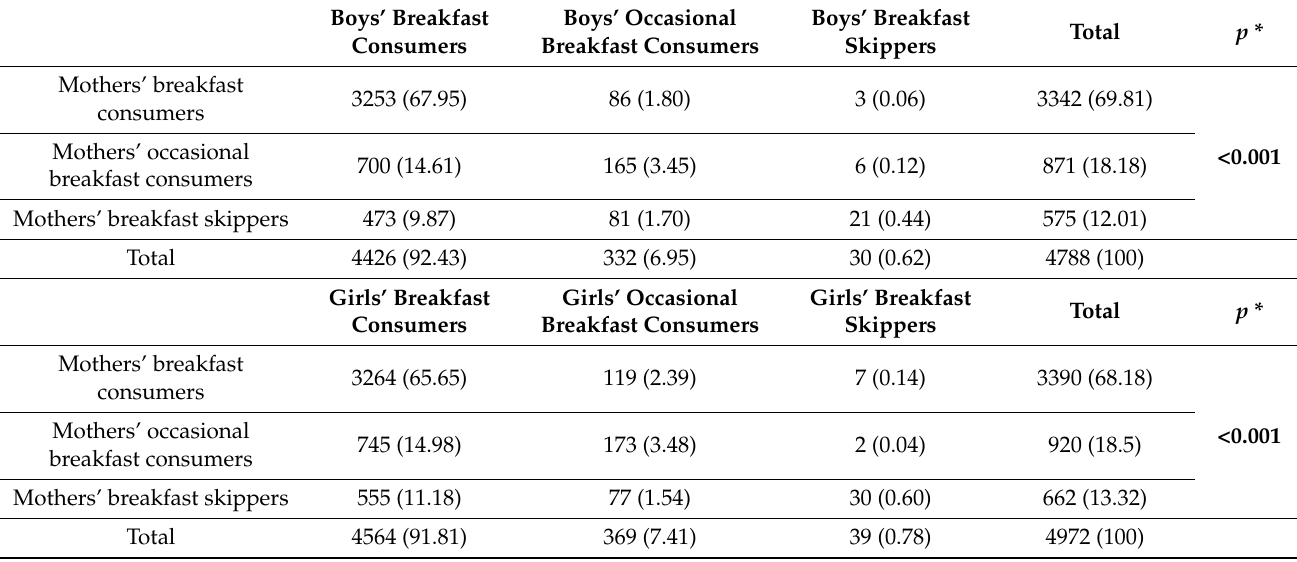
Table 4. Crosstab between mothers’ and boys’ and girls’ breakfast routine. Boys’ Breakfast Boys’ Consumers